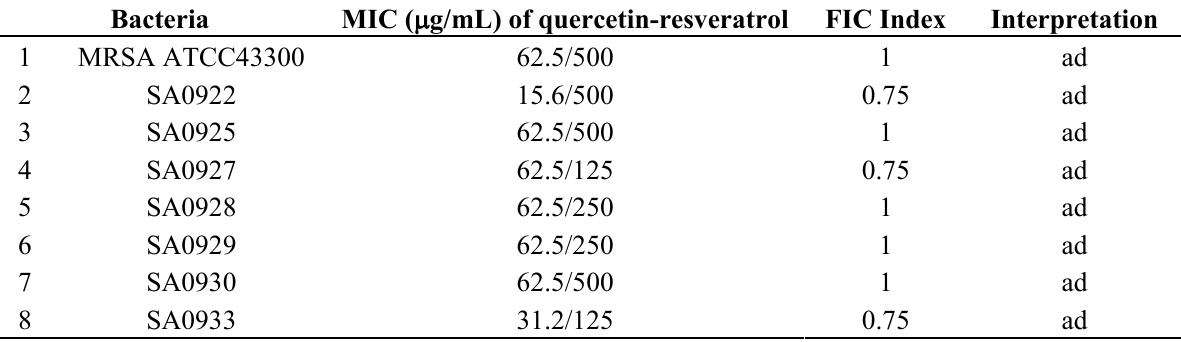
Table 4. FIC indexes of two-drug combination of quercetin-resveratrol against 30 MRSA